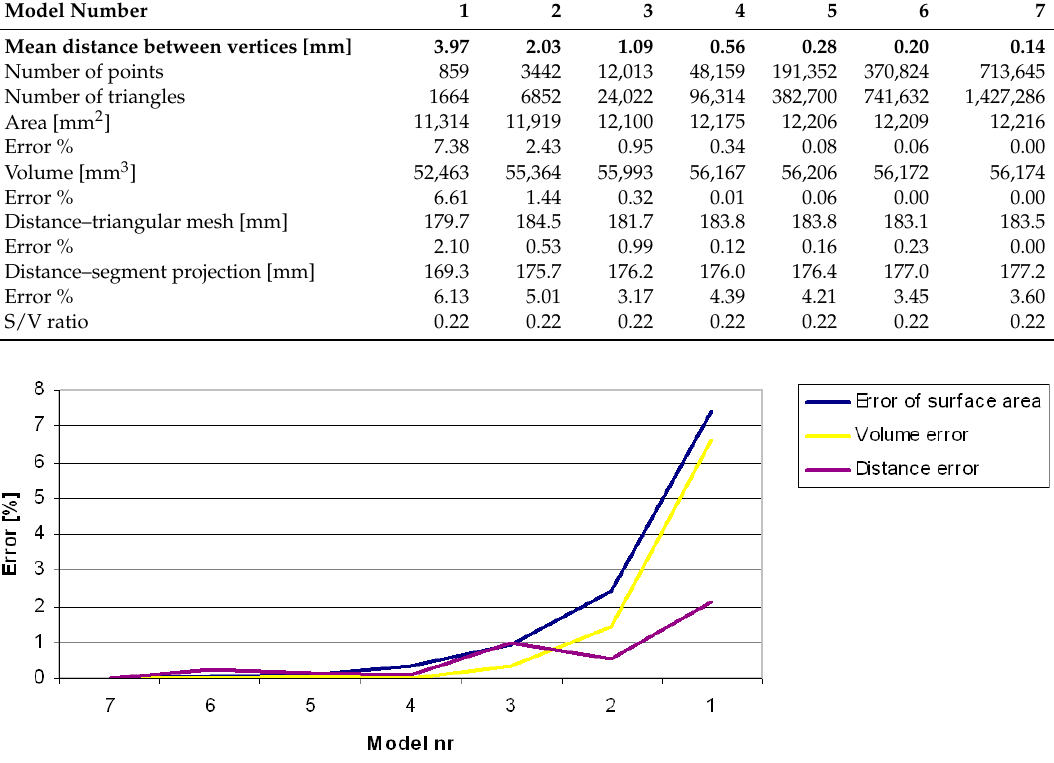
Figure 5. Relation between model resolution and measurement errors.